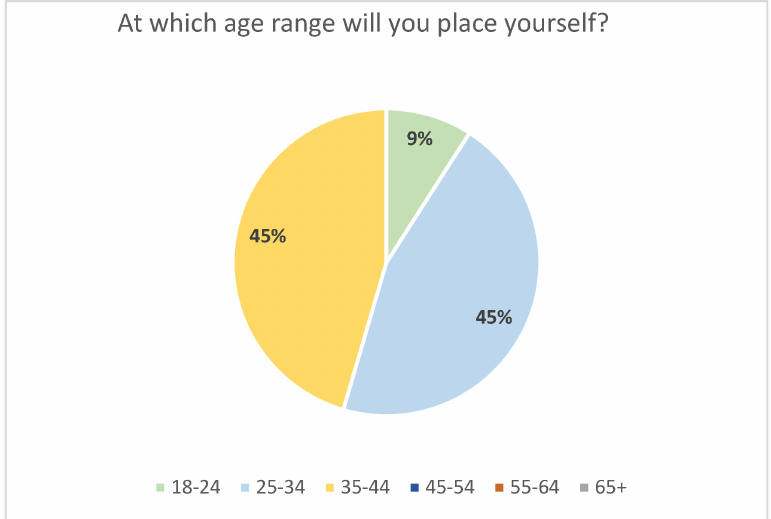
Figure 8. Age group of